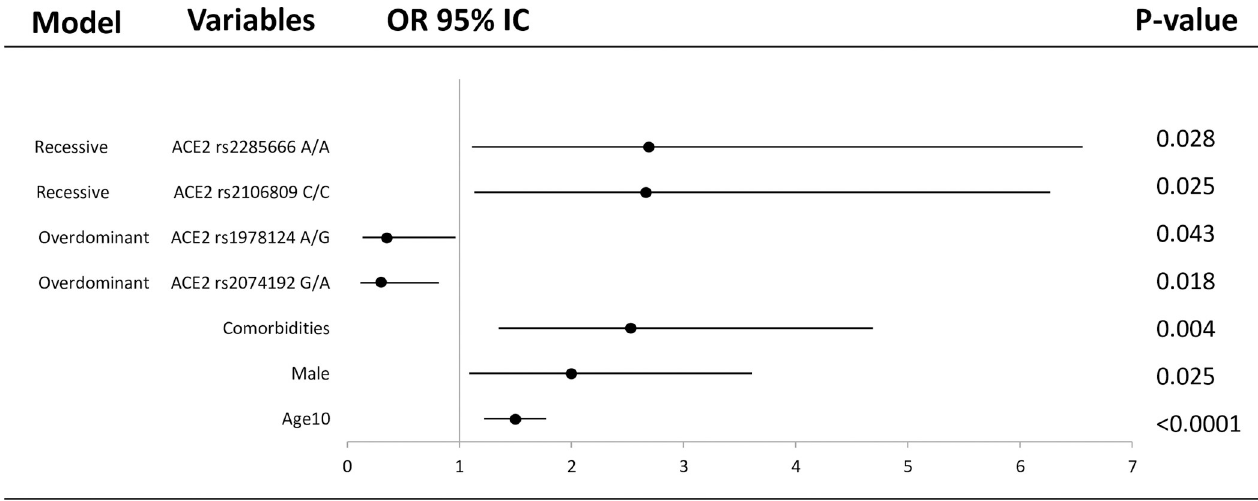
Fig 1. Forest plot of different covariates included in the association study of selected SNPs for estimation of OR of ICU+deceased vs outpatient individuals. The horizontal lines correspond to the study specific OR and 95% CI. Each of the SNPs were included separately in different models with age(10), gender and comorbidities as covariates. Age(10) represents OR per 10 years increase. https://doi.org/10.1371/journal.pone.0263140.g001 PLOS ONE | https://doi.org/10.1371/journal.pone.0263140 February 4,